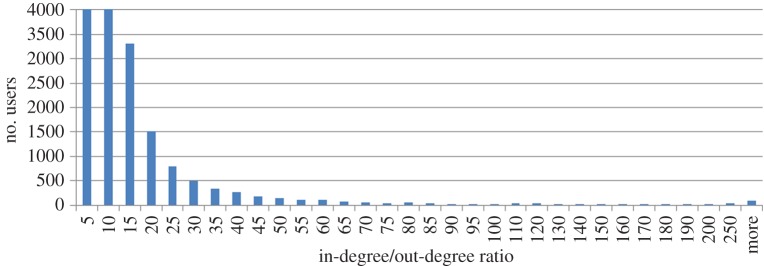
In-degree to out-degree ratio. The first two bars have been truncated to zoom in on values greater than 10. The bin-range starts from the value of the previous bin (exclusive) up to the value under the bin (inclusive). The increase in the bin height of the last two bins is due to the increased range of the bin which includes all users with ratio from 200 to 250 and greater than 250, respectively.